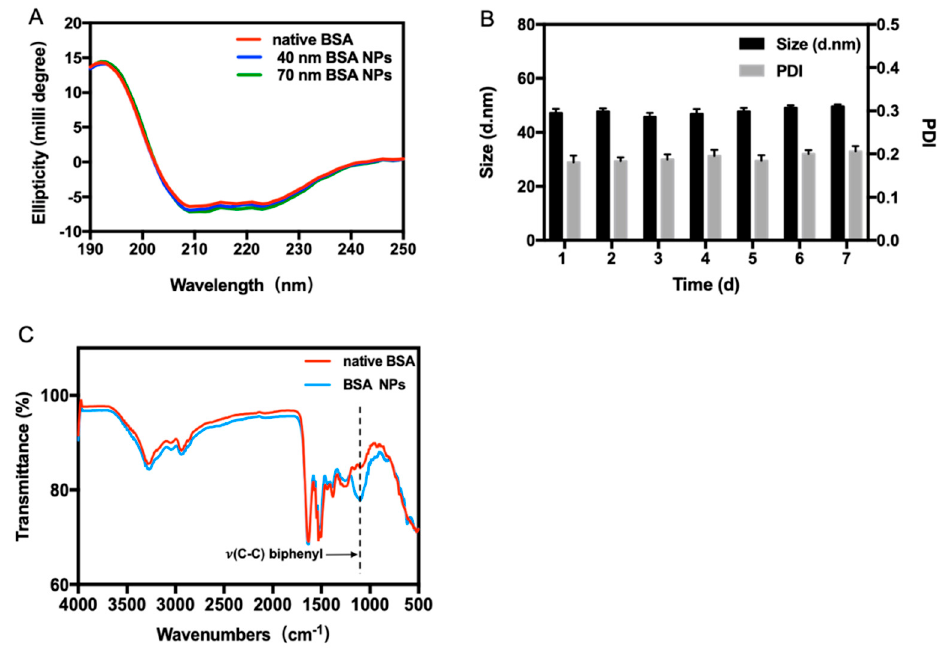
Figure 2. Secondary structure, stability property, and Fourier transform infrared spectroscopy (FTIR) characterization of BSA NPs. ( A ) Far-UV circular dichroism (CD) spectra of native BSA and BSA NPs of different sizes. Representative spectra are the average of three consecutive scans and smoothed with a Savitzy − Golay least-squares fit. ( B ) Change of the particle size of BSA NPs over a period of 7 d according to DLS measurements. The sample was stored in PBS (pH 7.4, 150 mM NaCl) at 4 ◦ C. ( C ) FTIR spectra of native BSA and BSA NPs.